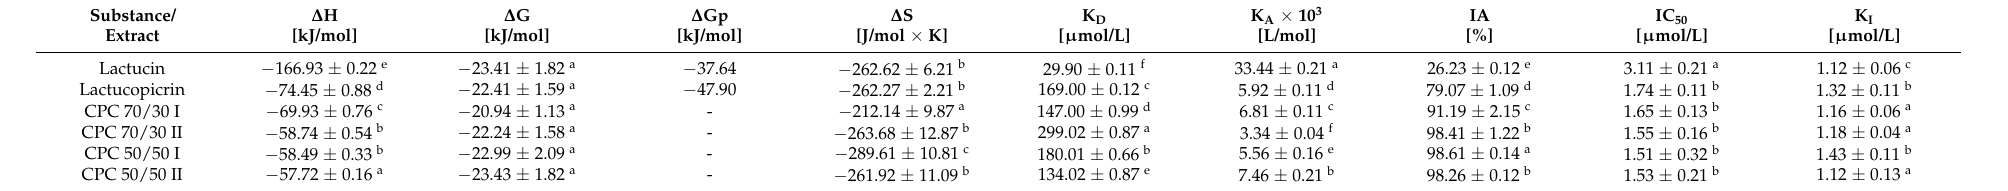
Table 2. Thermodynamic parameters of the interaction of chicory extracts with AChE based on the ITC analysis. ∆ H Substance/ Extract